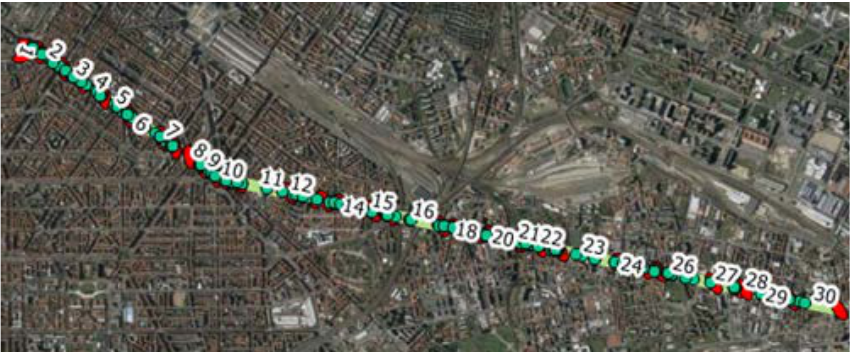
Figure 9. Subdivision in homogeneous zones of the route for the second experimental phase (QGIS elaboration of Google Maps).